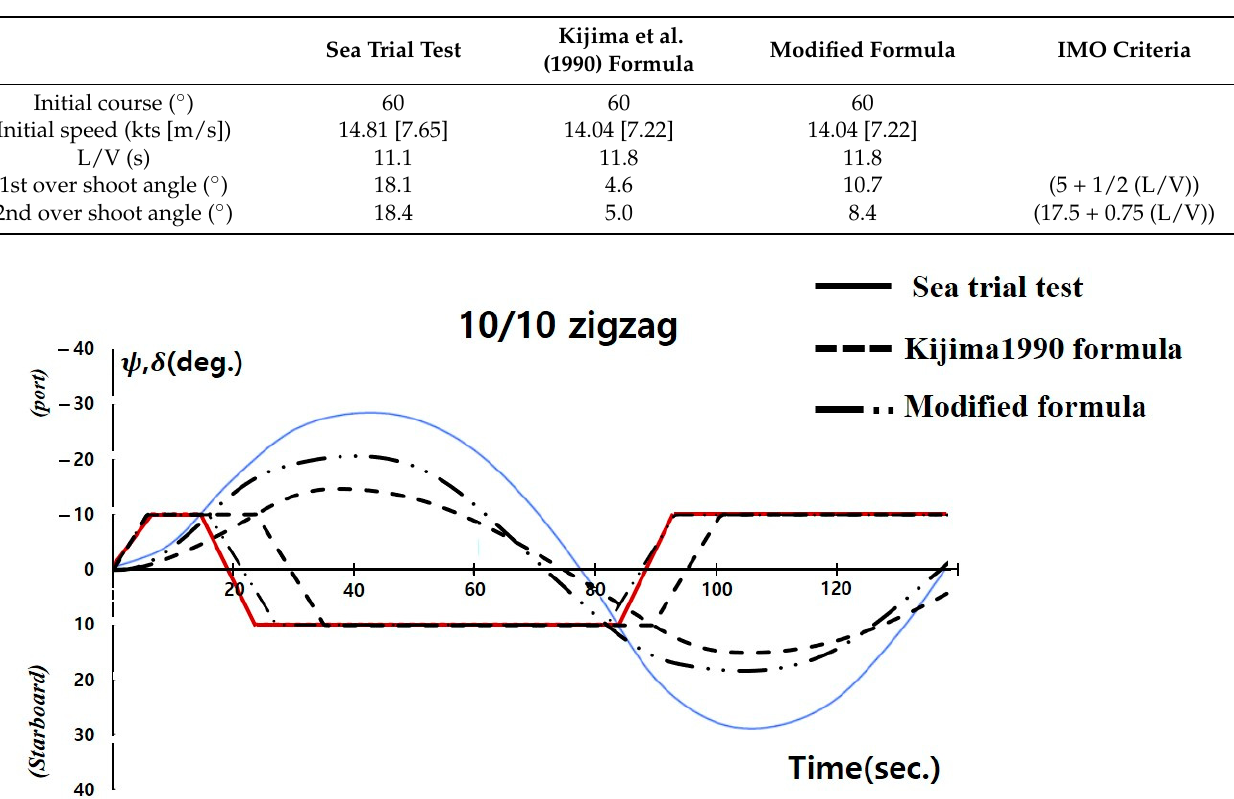
Table 9. Comparison of the 10/10 zigzag test results for the target trawler.